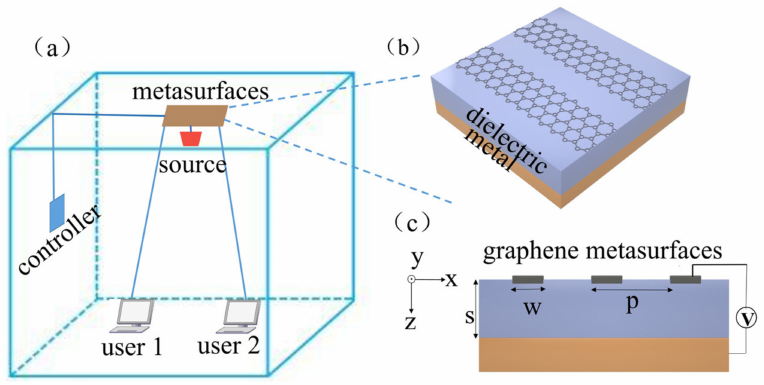
Figure 1. ( a ) Indoor THz communication scheme for multi-user scenarios. ( b ) Schematic of a graphene metasurface that consists of a metal substrate, a dielectric layer, and top graphene ribbons. ( c ) A sectional view of the graphene metasurface. p is the grating period, w is the width of the graphene ribbon and s is the thickness of the SiO 2 dielectric